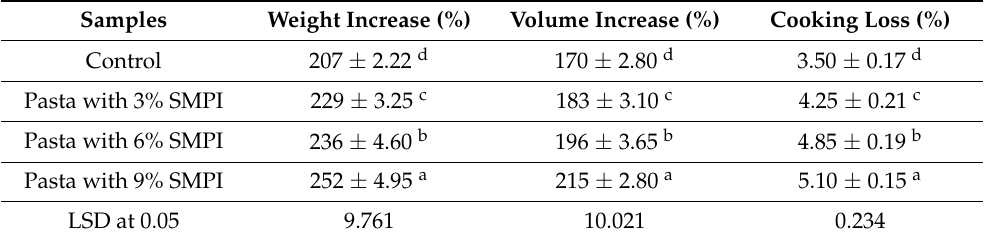
Table 6. Impact of mixing SMPI with wheat flour on the cooking quality of pasta.